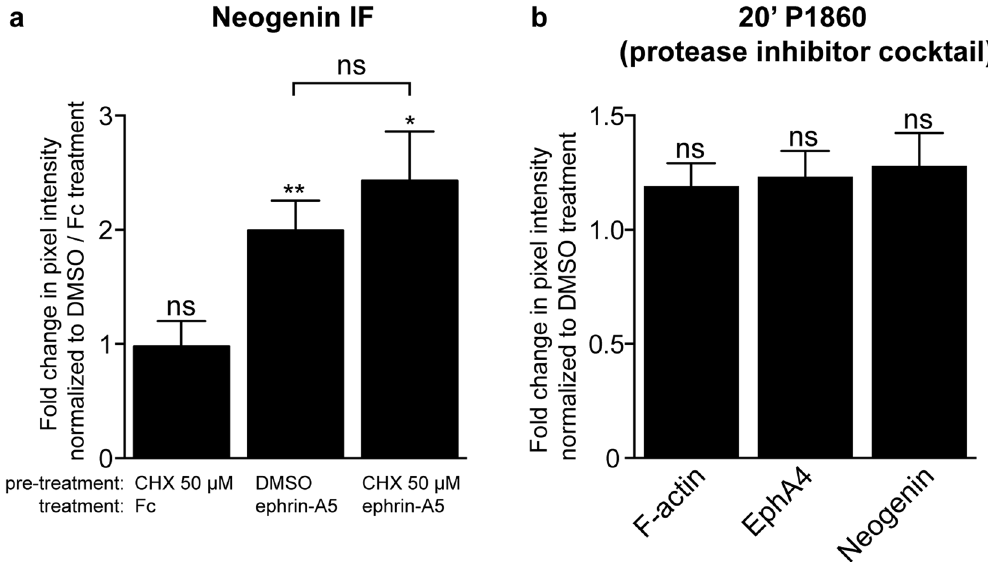
Figure 7. The ephrin-A5 induced increase in Neogenin protein levels in LMC growth cones may occur independently of protein synthesis and proteolytic degradation. ( a ) Quantification of Neogenin IF in LMC growth cones pre-treated for 20 ′ with either DMSO or CHX 50 µ M followed by a 5 ′ treatment with either Fc or ephrin-A5 500 ng/mL. The inclusion of CHX did not significantly change Neogenin IF in growth cones treated with ephrin-A5 (p = 0.4177). ( b ) Relative to DMSO, a 20 ′ treatment with a protease inhibitor cocktail (P1860, 1/200) failed to increase the levels of F-actin (p = 0.0828), EphA4 (p = 0.0647) and Neogenin IF (p = 0.0769) in growth cones of LMC explant cultures. Data are shown as mean ± SEM, statistical significance was tested using a two-tailed unpaired sample t-test. ( a , b ) N =